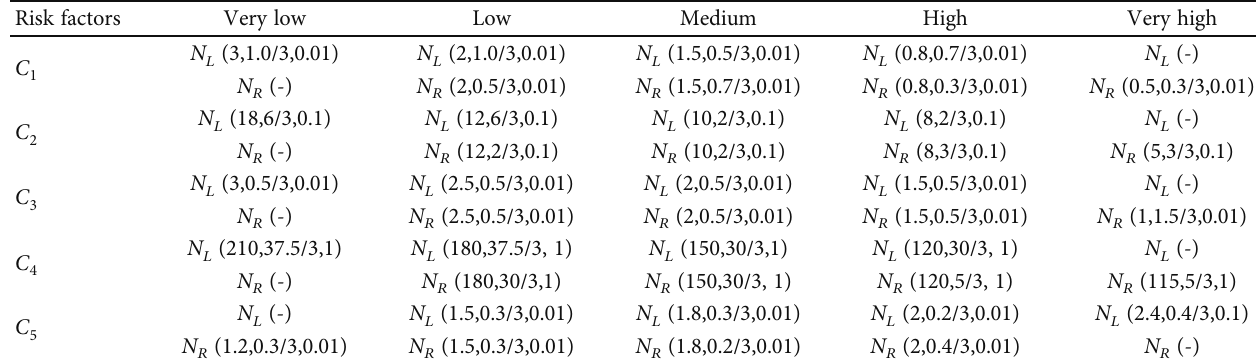
Table 2: Grade standard and grey cloud whitening weight model for CRI of overtaking situation.